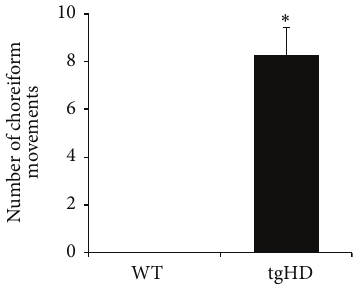
Figure 4: The graph represents the number of choreiform move- ments scored during 20 minutes. The values are presented as mean ± standard error of the mean (SEM) and statistically significant difference ( 𝑃 < 0.05 ) is indicated by an ( ∗